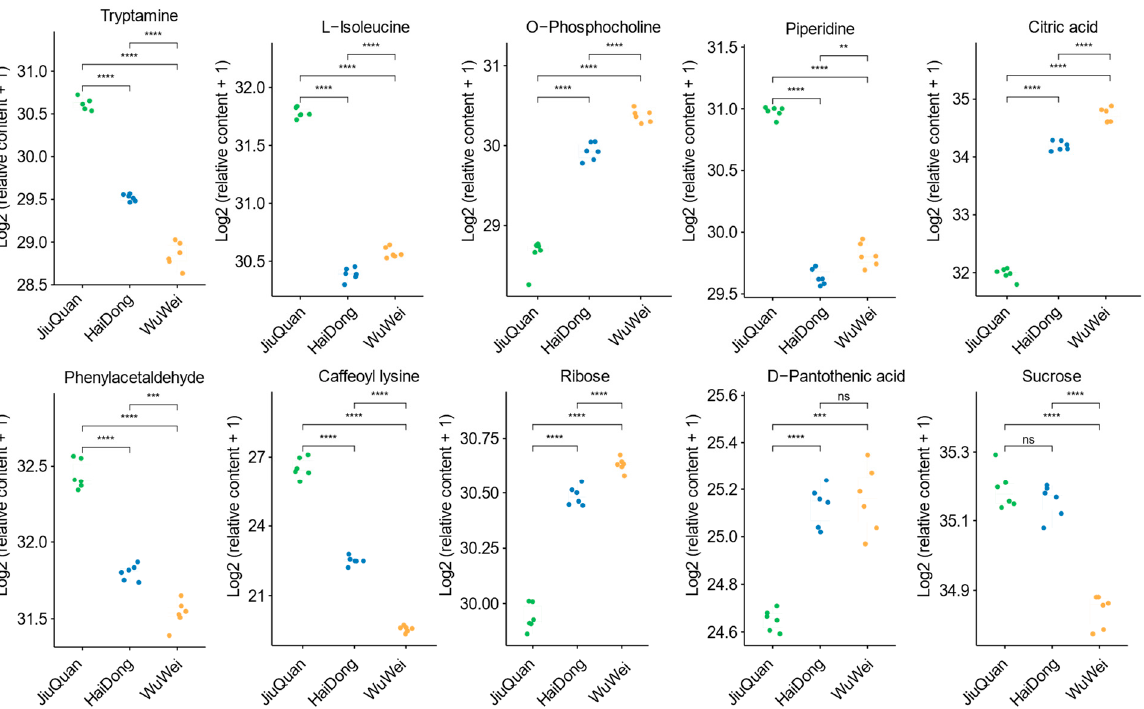
Figure 4. Compounds with the most significant differences in each category of differential metabolites. p > 0.05 (ns), p < 0.01 (**), p < 0.001 (***), p < 0.0001 (****). Sucrose was second only to ribose in